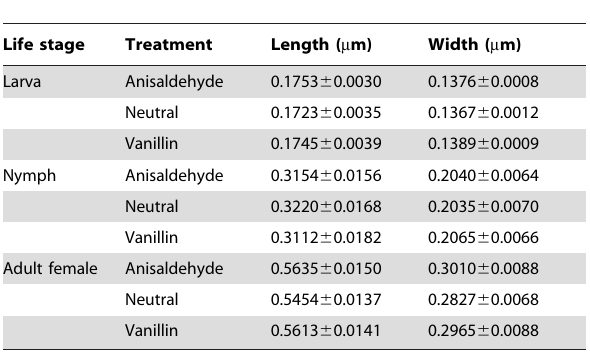
Figure 1. The effects of prenatal learning on residence preference of predatory mite protonymphs. Mean ( 6 SE) proportion of N. californicus protonymphs preferentially residing in the vicinity of spider mites matching the type in their maternal diet. Protonymphs originated from mothers fed on neutral, vanillin- or anisaldehyde-flavored spider mites and were given a binary choice between dead spider mites matching the maternal diet and non- matching spider mites ( n =24 for each of the six choice situations).